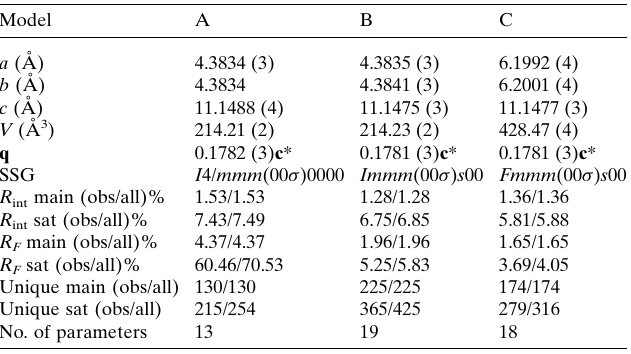
Table 2 Crystallographic data for the three models for the modulated crystal structure at 70 K, based on different superspace groups. Criterion of observability: I > 3 (cid:2) ( I